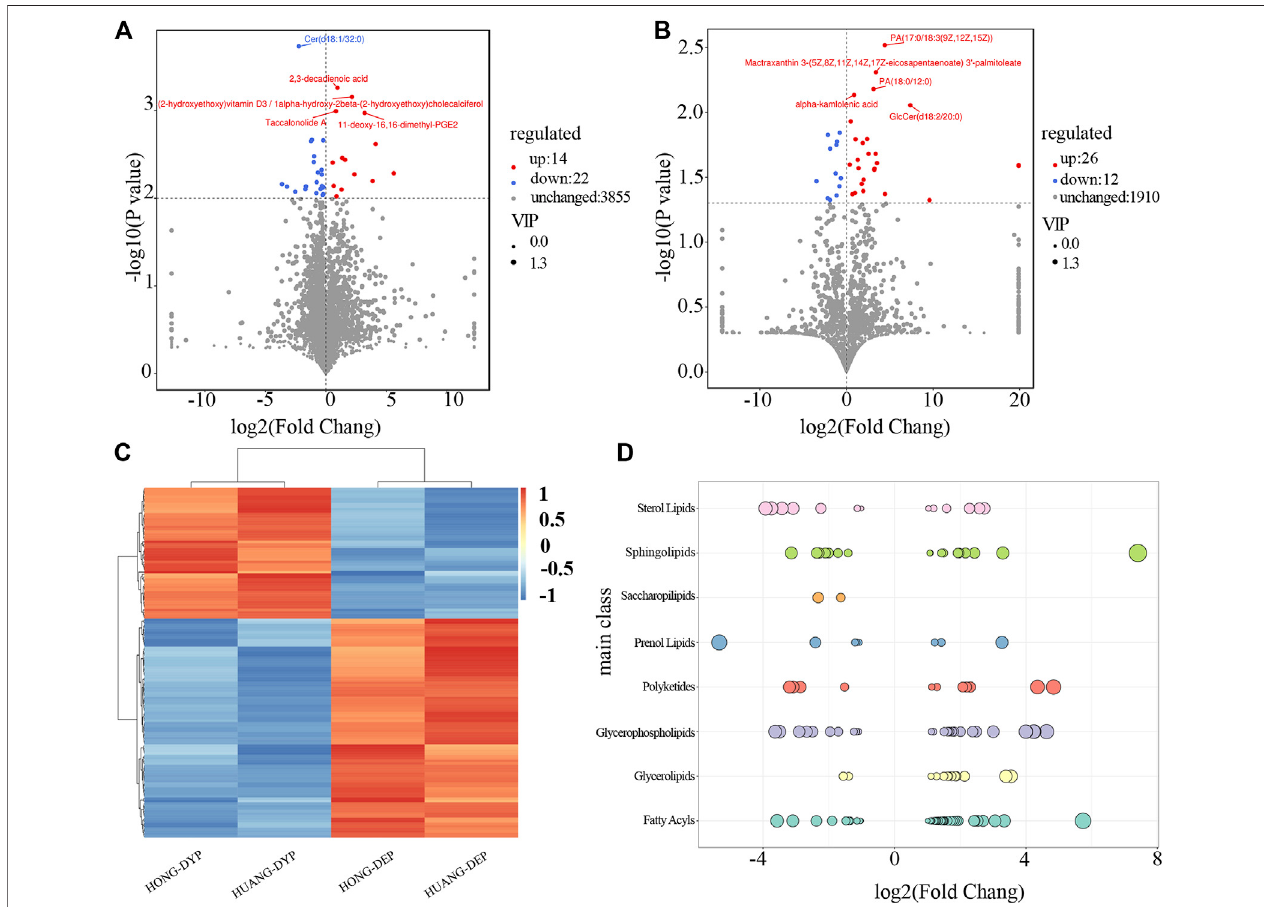
FIGURE4| AnalysisofdifferentiallipidmoleculesinFFfromMayand Julysamplingdates.Characteristicsofdifferentiallipid moleculesofFFinESI-positive (A) and ESI-negative (B) ion modes. The dots represent lipid molecules, among which the blue (down regulated) and red dots (up regulated) that satis fi ed FC < 0.5, FC > 2, and p < 0.05 indicating signi fi cant differences between the two sample dates (C) Hierarchical and clustering analysis (D) Representation of signi fi cantly different lipid distributions at different stages. Each dot represents a lipid, and the larger the dot, the greater the difference in lipids across sampling dates. Log2FC is the logarithmic value ofthelipid content ofthetwogroups. Log2FC > 0 meansthat thelipid content increased fromthe May toJulysample,and Log2FC < 0means thatthe lipid content decreased in from the May to July